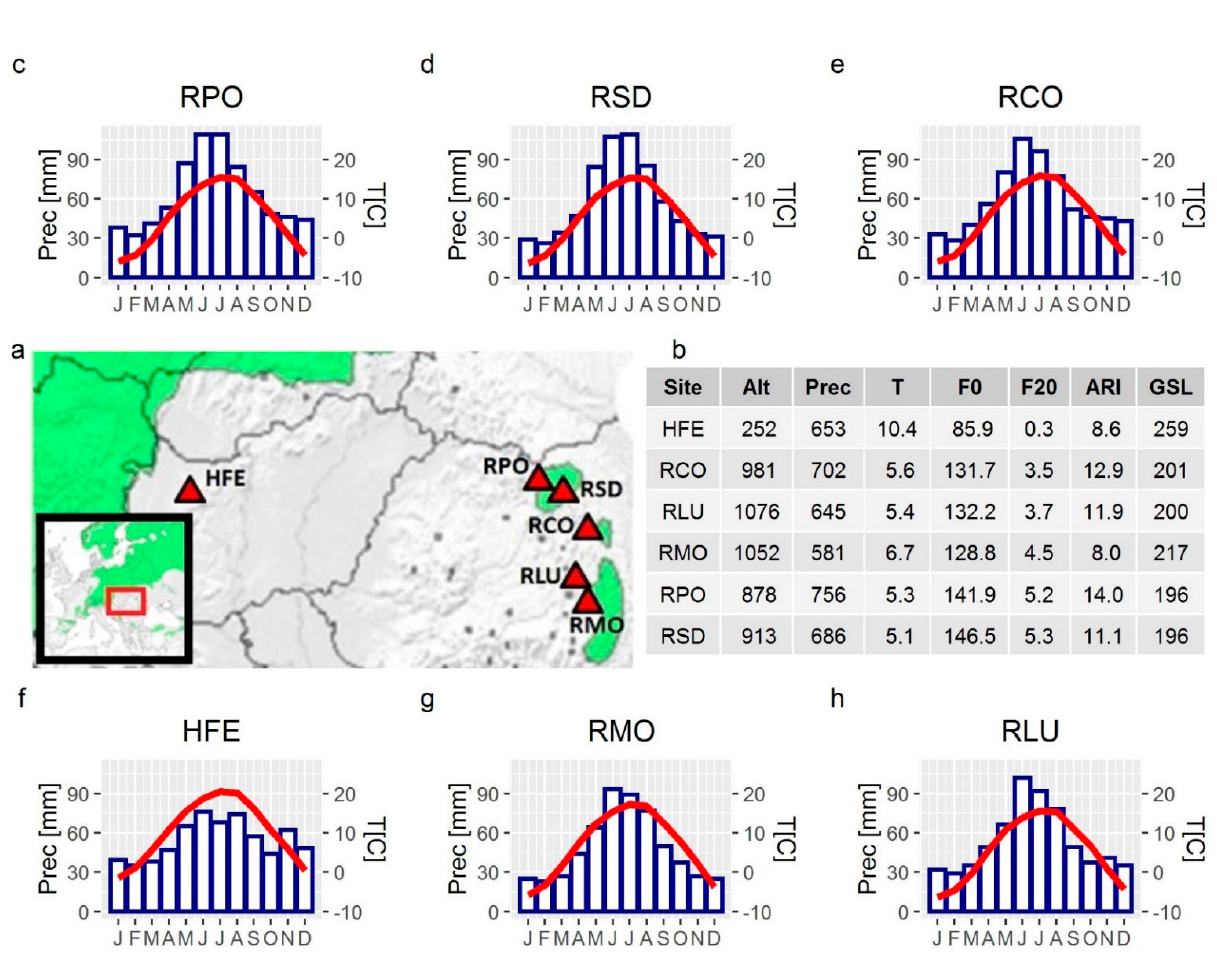
Figure 1. Natural distribution of Pinus sylvestris in Europe (subfigure green area) and in the Carpathian region (green area), together with the geographic position of sampled Pinus sylvestris populations ( a ) with the altitude (Alt), total yearly precipitations (Prec), average yearly temperatures (T), number of frost days with minimum temperatures below 0 °C (F0), number of frost days with minimum temperatures below − 20 °C (F20), global aridity indexes (ARI), and average growing season length (GSL) of the sites ( b ), and the corresponding climate diagrams of the sites ( c – h ). Blue bars represent monthly precipitation sums, and red lines represent monthly mean temperatures in the climate diagrams, calculated over the period 1961–2010 and derived from the CARPATCLIM database. Site abbreviations: Suhardul Mic (RCO), Tinovul Luci (RLU), B ă ile Tusnad (RMO), Poiana Stampei (RPO), Saru Dornei (RSD), Feny ő f ő (HFE).